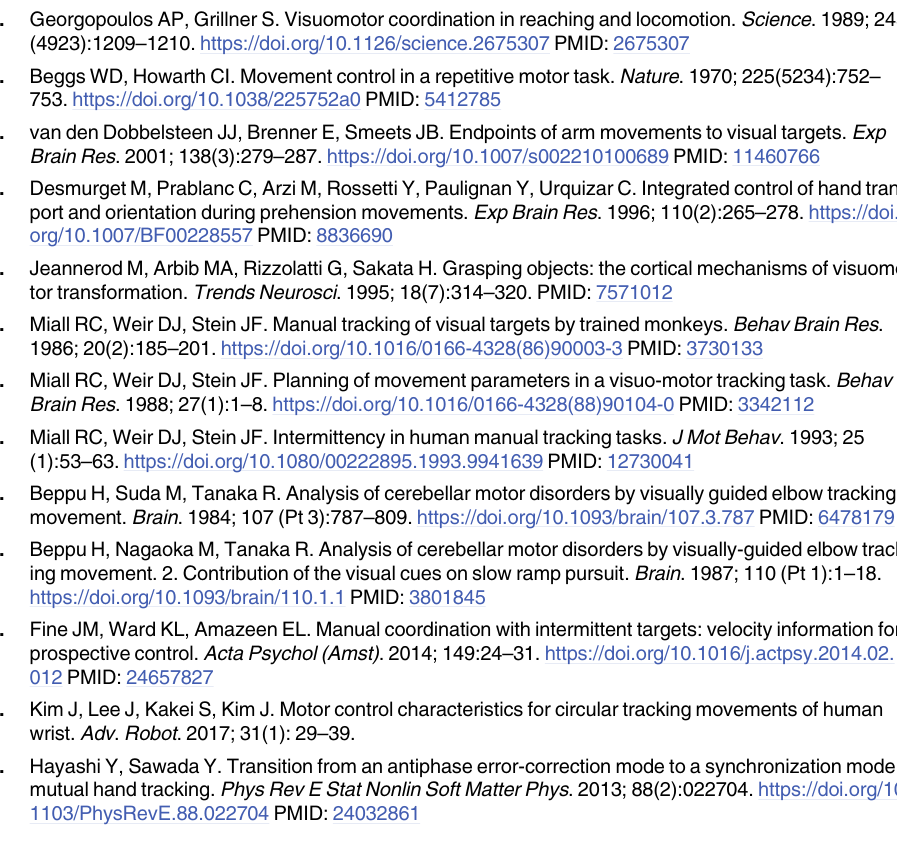
S1 Table. Summary of statistical analysis results for Δ θ . S2 Table. Summary of statistical analysis results for Δ ω